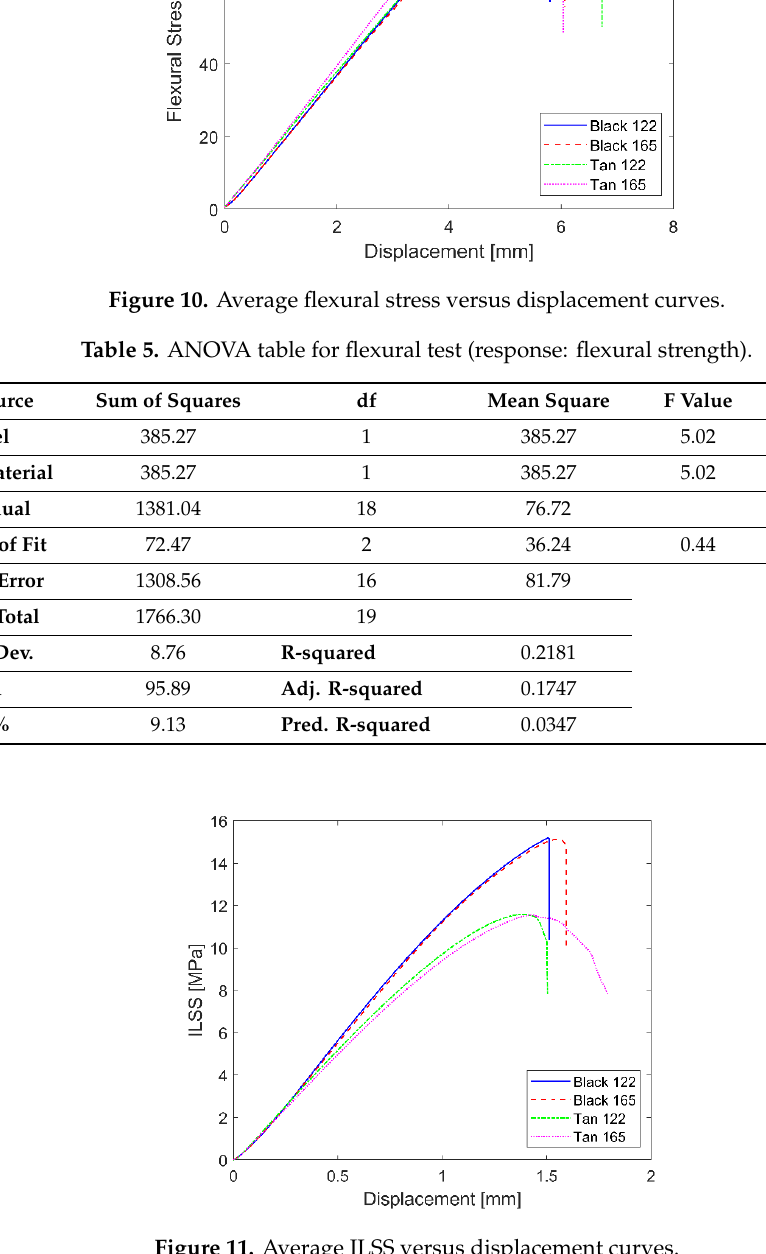
0.9058 Figure 12. Normal probability plot for SBS test.